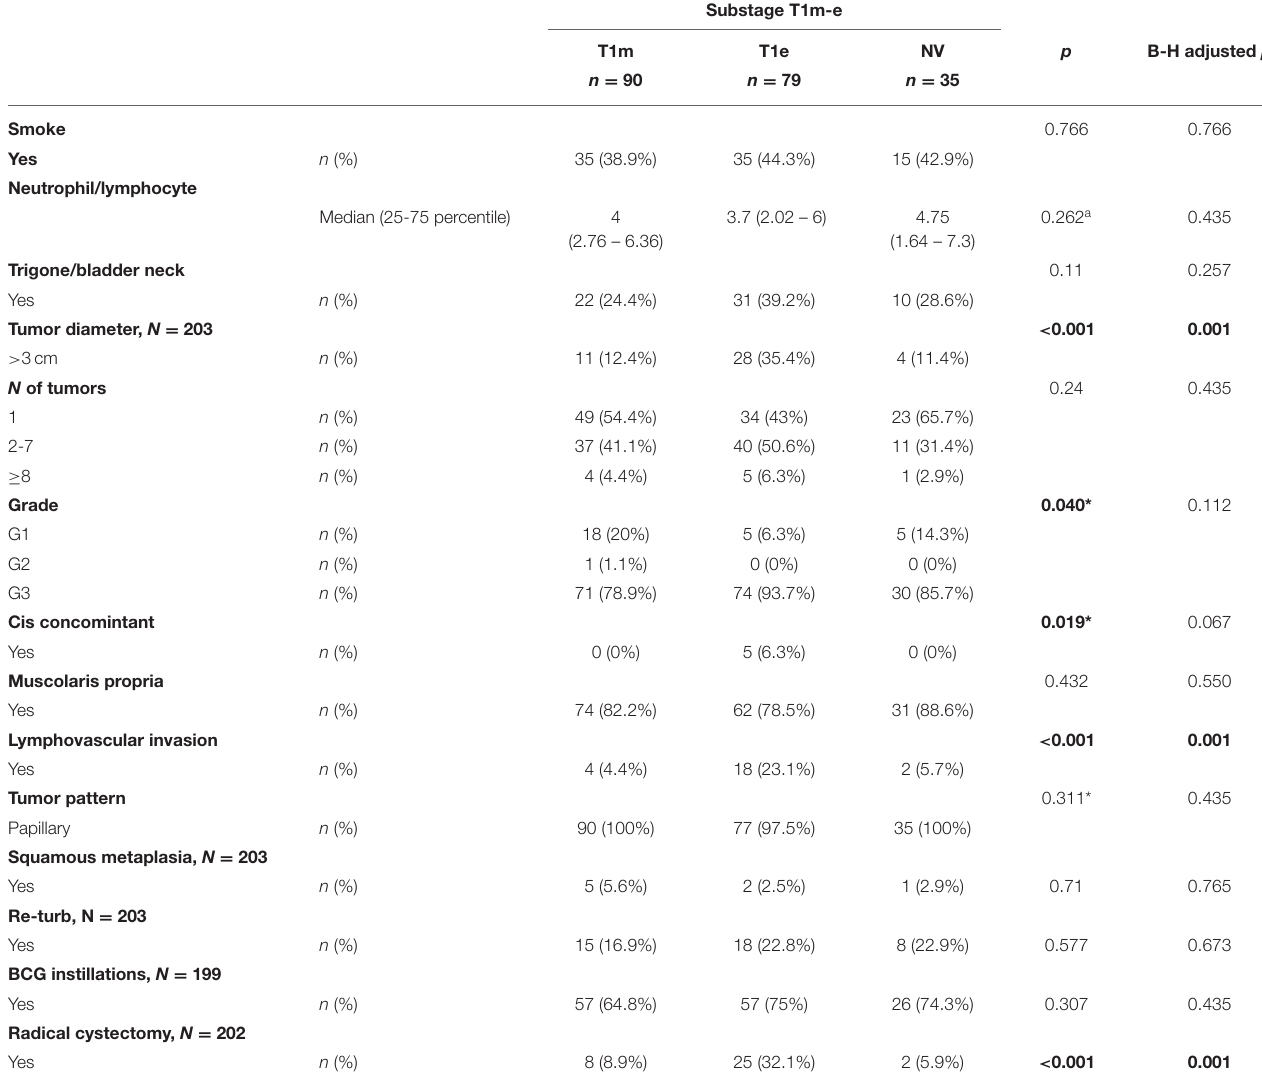
TABLE 4 | Association between subcategory T1m-e and other